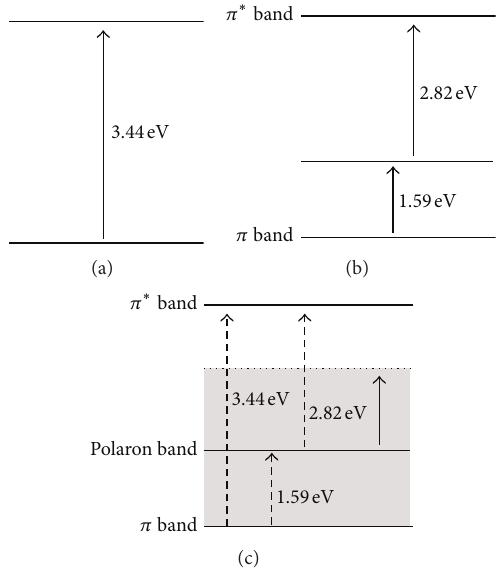
Figure 6: Energy band structure of (a) emeraldine base, (b) doped PAN, and (c) doped PAN under high